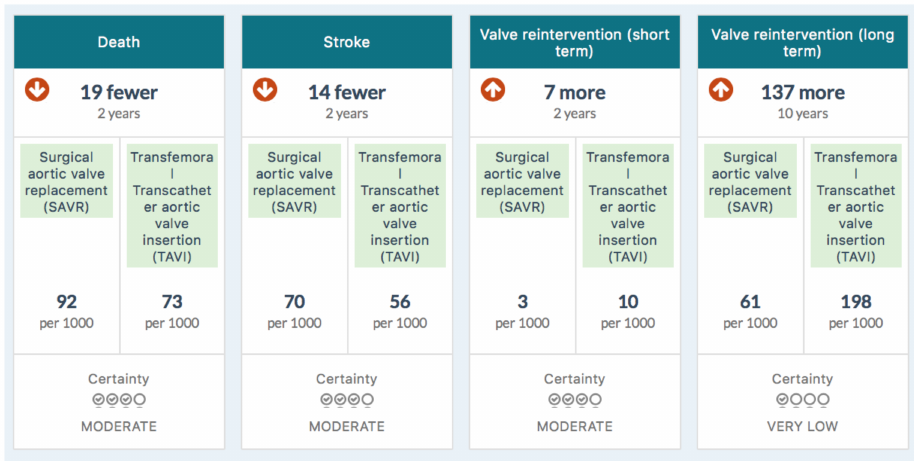
Figure 1. Infographic in Making GRADE the Irresistible Choice (MAGIC) aid for 65–75 year-olds.